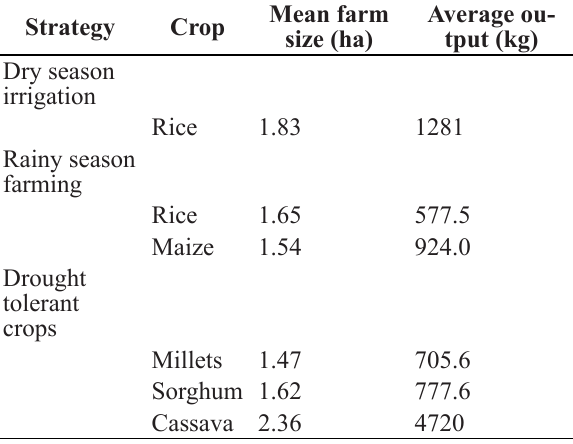
Table 1: Area of land used for different adaptation strategies by the respondents